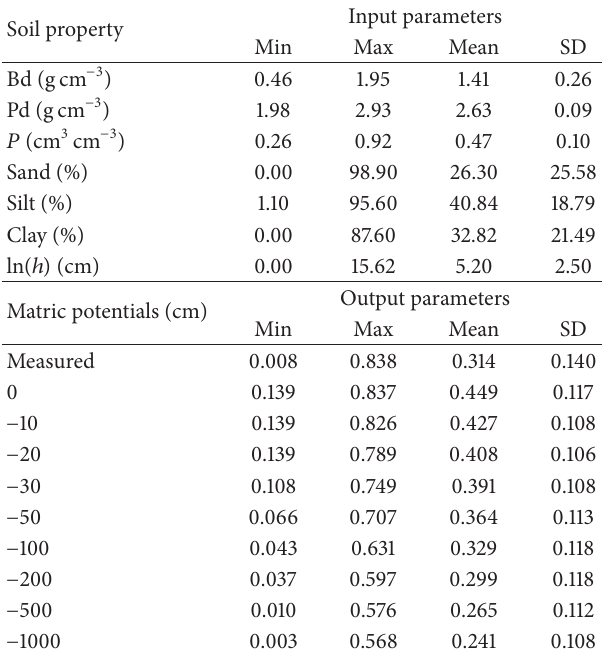
Table1:Descriptivestatisticsofsoilpropertiesassumedasinputand output parameters in the developed ANNs (all 228 soil